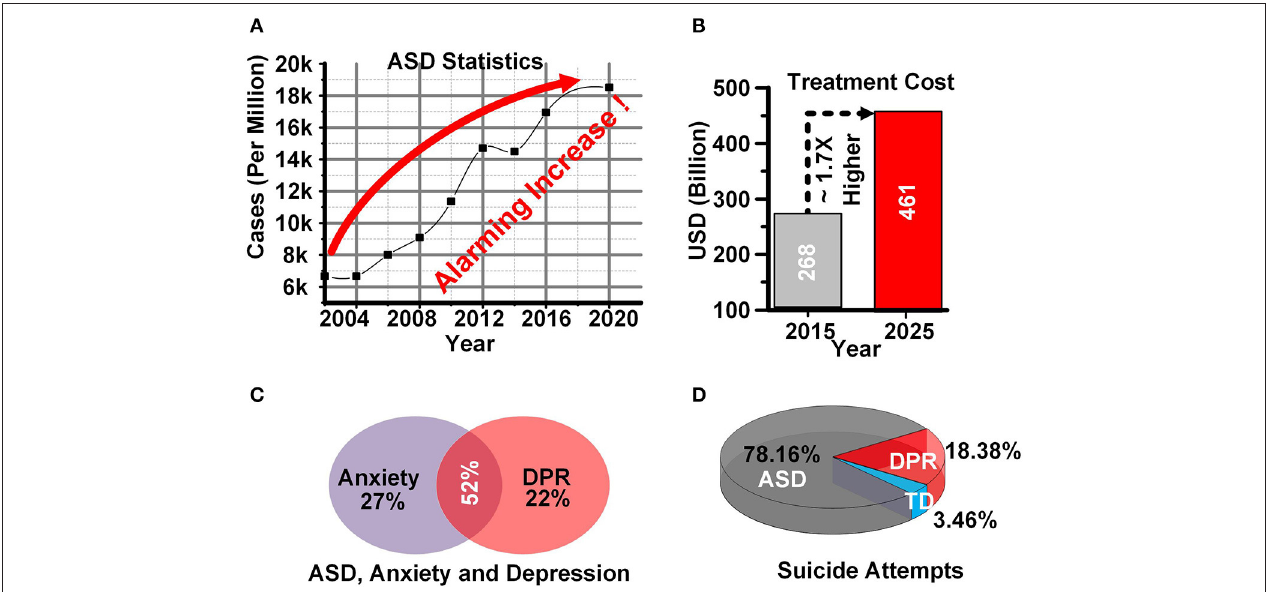
FIGURE 1 | (A) ASD statistics (B) ASD treatment cost (C) ASD, anxiety and depression (D) Suicide attempts in